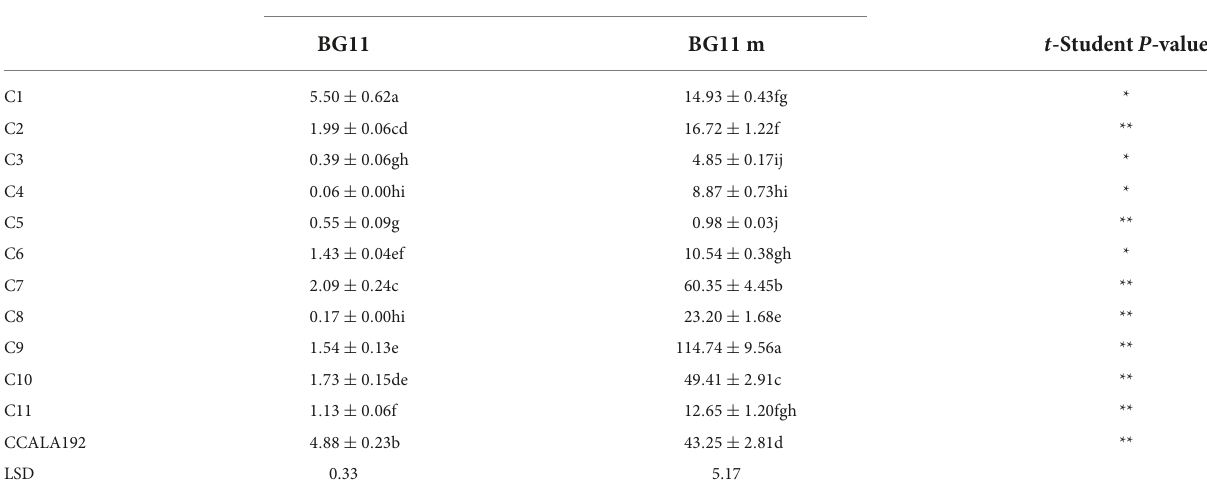
TABLE 3 Carotenoids contents recorded for “Stiffe” caves’ cyanobacteria and Synechocystis cf. salina , grown in BG11 0 and BG11 modified for